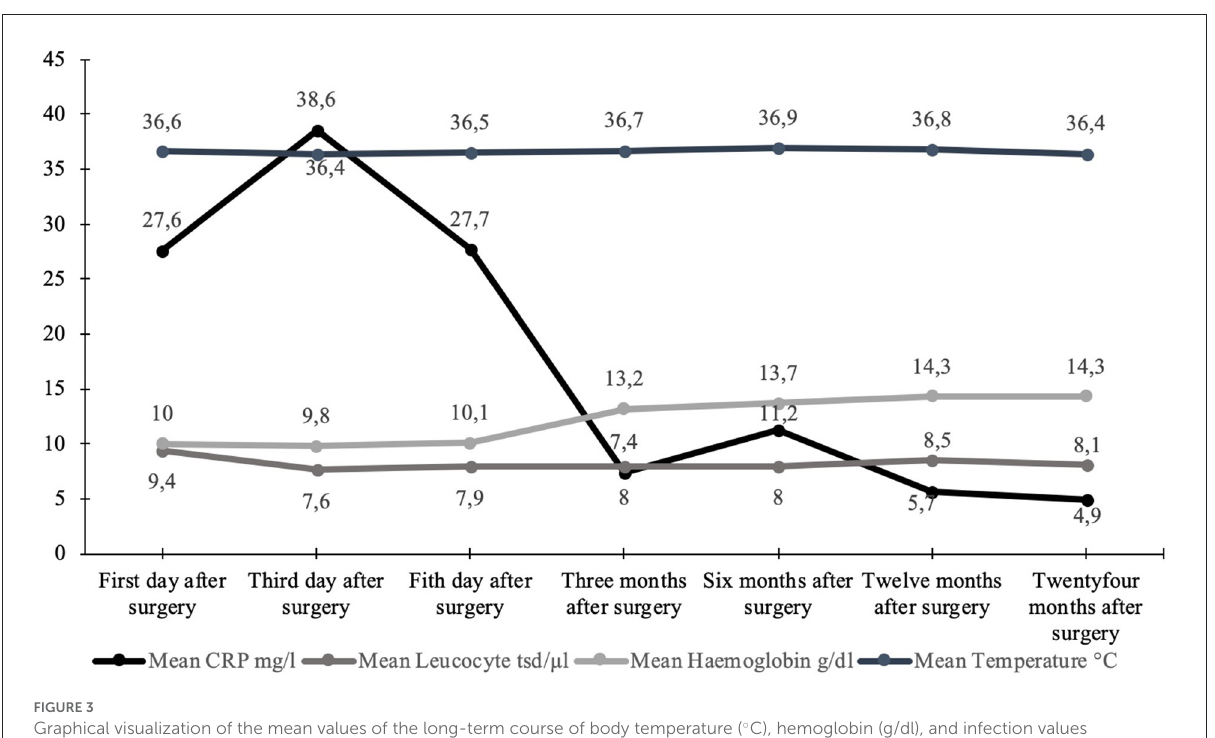
FIGURE3 Graphical visualization of the mean values of the long-term course of body temperature ( ◦ C), hemoglobin (g/dl), and infection values [leucocytes (tsd/ µ l) + CRP